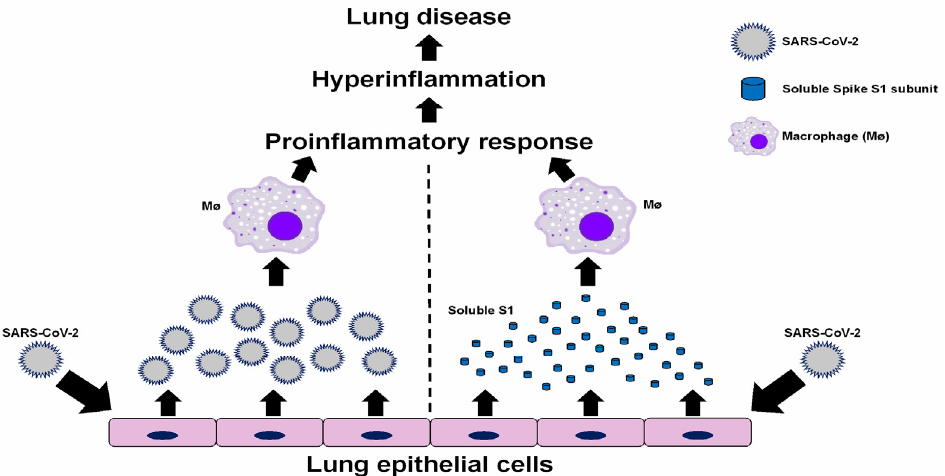
Figure 4. Proposed contribution of SARS-CoV-2 and soluble S1 to inducing inflammatory responses by macrophages. SARS-CoV-2 virions and soluble S1 proteins released from productively infected lung epithelial cells trigger proinflammatory responses by macrophages, which then contribute to hyperinflammation and lung disease associated with COVID-19.